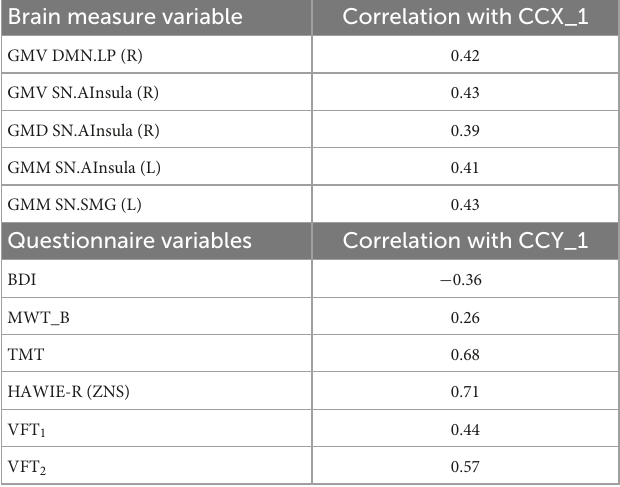
TABLE 5 Correlation between canonical correlation analysis (CCA) variates and variables for the sample of subjects with a current psychiatric diagnosis.